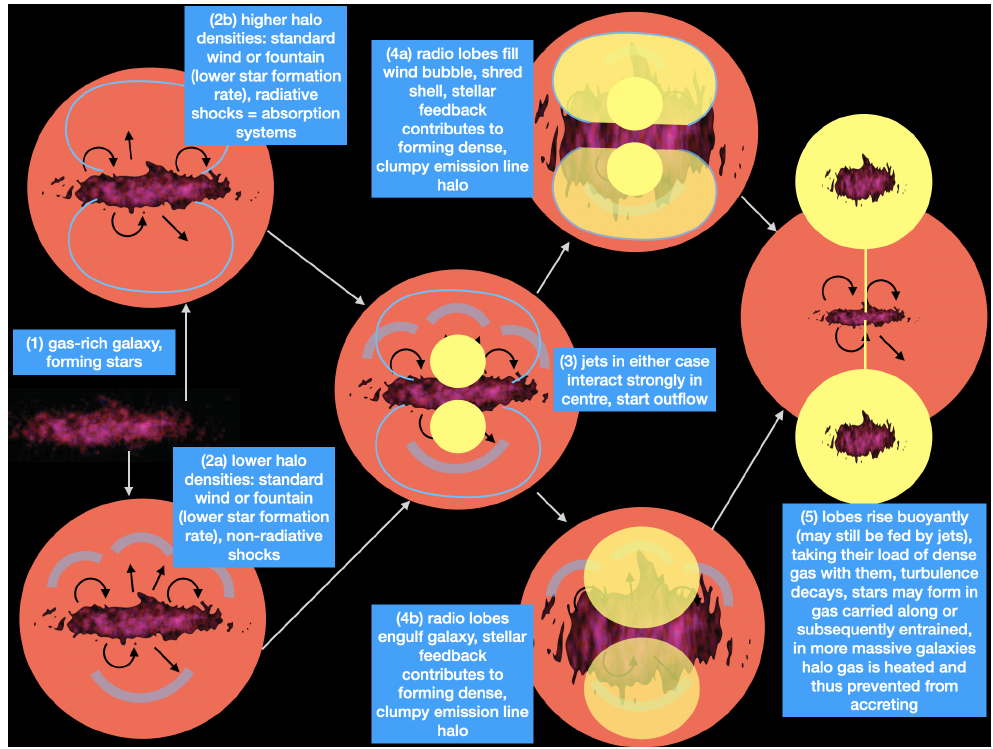
Figure 4. Sketch of the scenario of how jet feedback might work developed in this article. See Section 8 for more